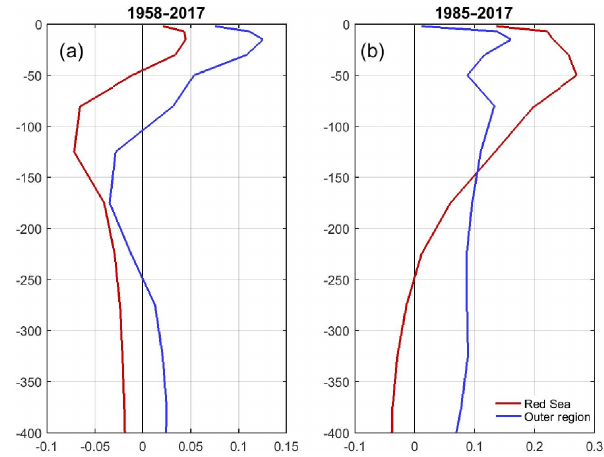
Figure 20. Vertical distribution of temperature trends (in ◦ Cdecade − 1 ) for the Red Sea (in red) and the Outer zone (in blue). The linear trends have been computed for the periods (a) 1958–2017 and (b) 1985–2017. Note the different horizontal axis in each